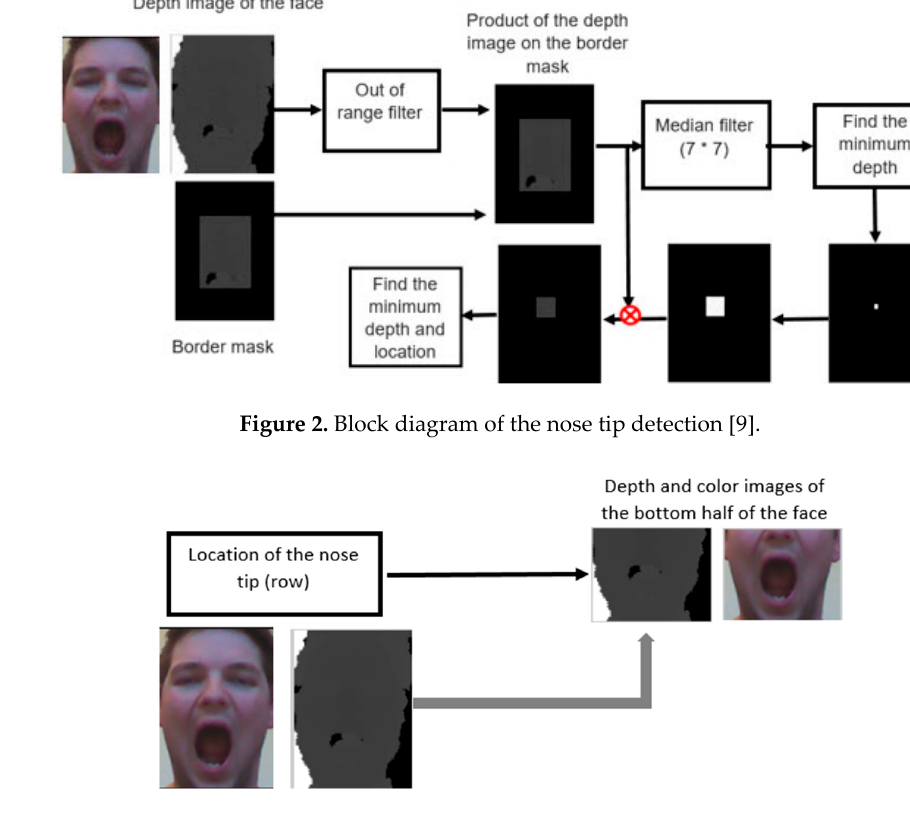
Figure 3 Block diagram for separating the bottom half of the